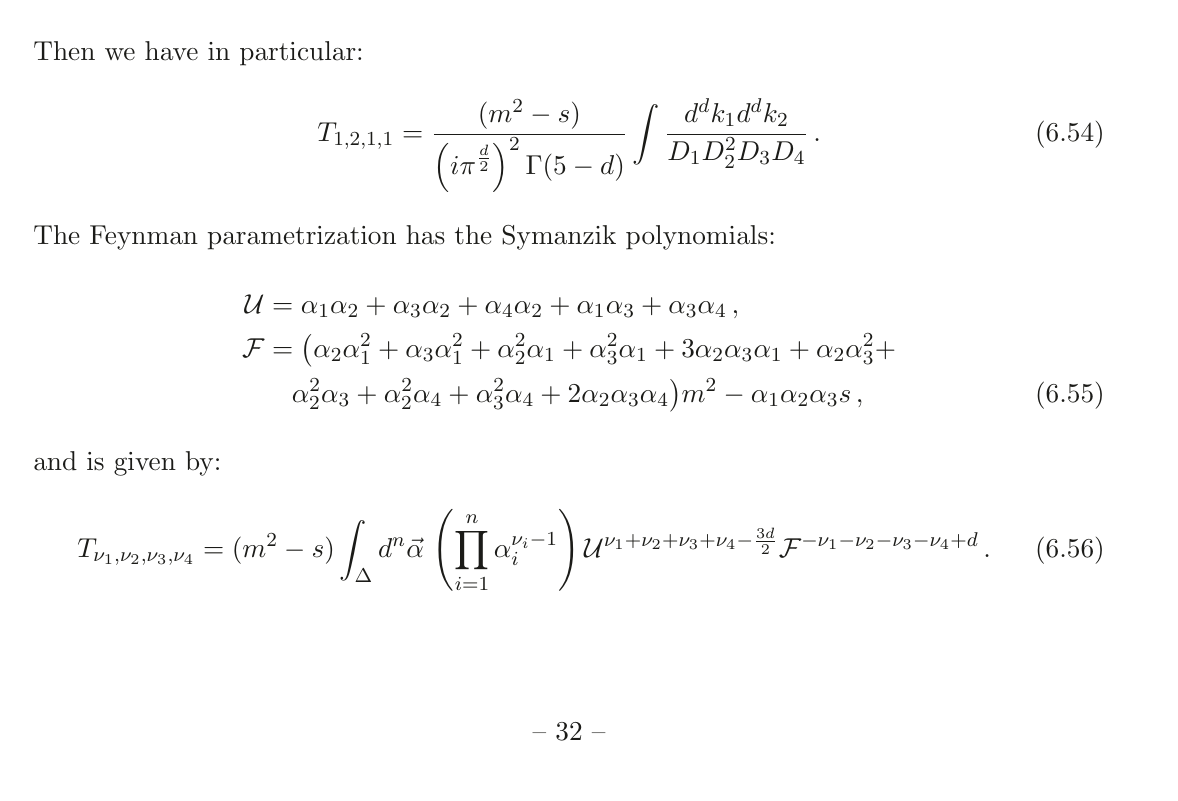
2 , m 2 , m 2 1 , 1 , 1 ( s, m 1 2 3